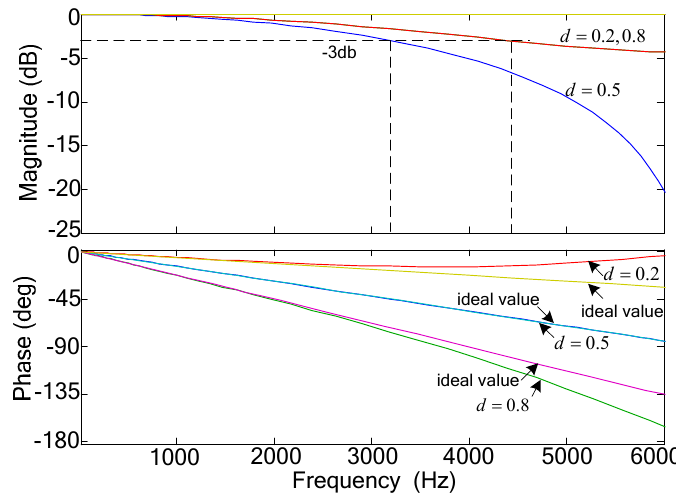
Figure 5. Bode plot of Fd(z).